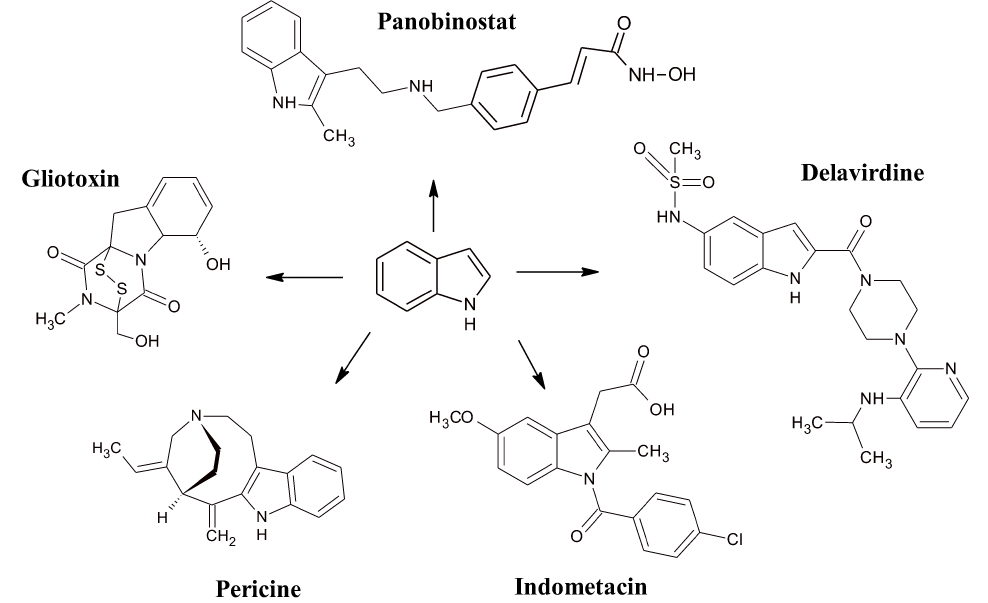
Figure 1. Pharmacologically active indole ring-containing